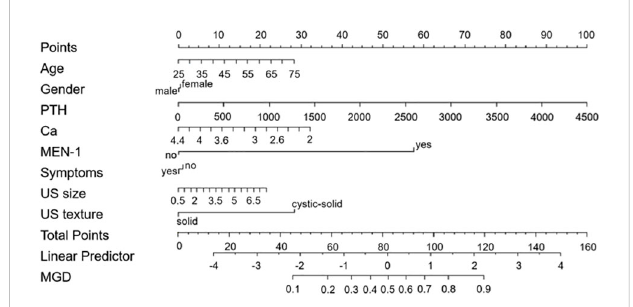
FIGURE 2 Nomogram predicting the probability of MGD for PHPT patients.